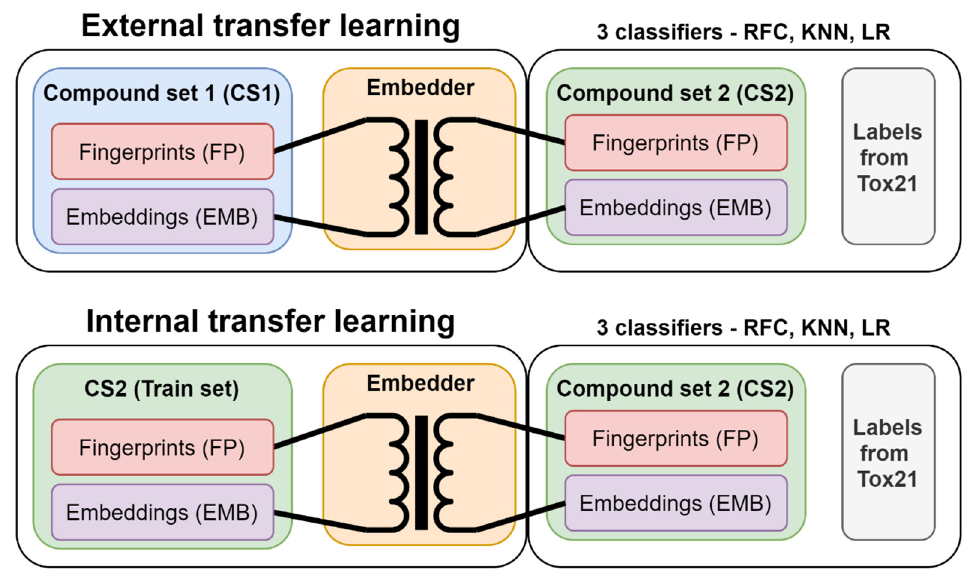
Figure 10. In external transfer learning, an embedder (PCA, UMAP, VAE) is fit on fingerprints on an external set of fingerprints (CS1). The same model (pre-trained embedder) is then utilized to encode fingerprints from CS2. In internal transfer learning, the embedder is fit on the pre-split train set of CS2 and used to encode the test set of CS2. The embeddings of CS2 were utilized for training predictive classification tasks.